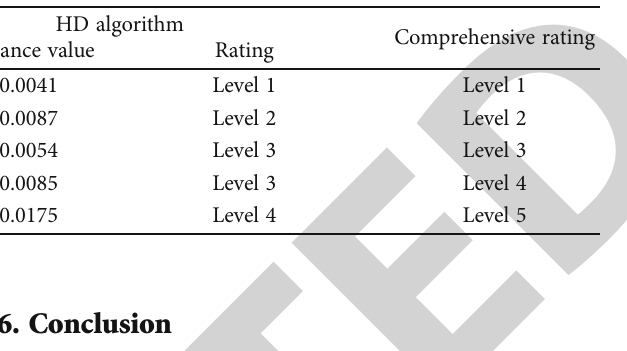
Table 1: Statistical results of action fl ow matching test